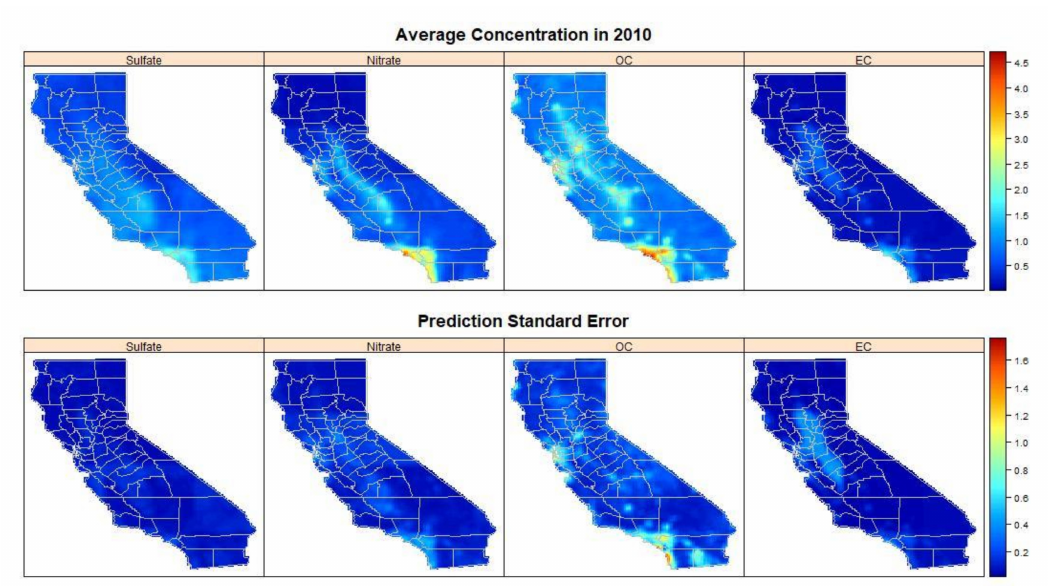
Figure 3. Estimated 2010 annual average of elemental carbon (EC), organic carbon (OC), sulfate, and nitrate in California. The prediction standard errors are for the annual averages. Concentration is given in µ g / m 3